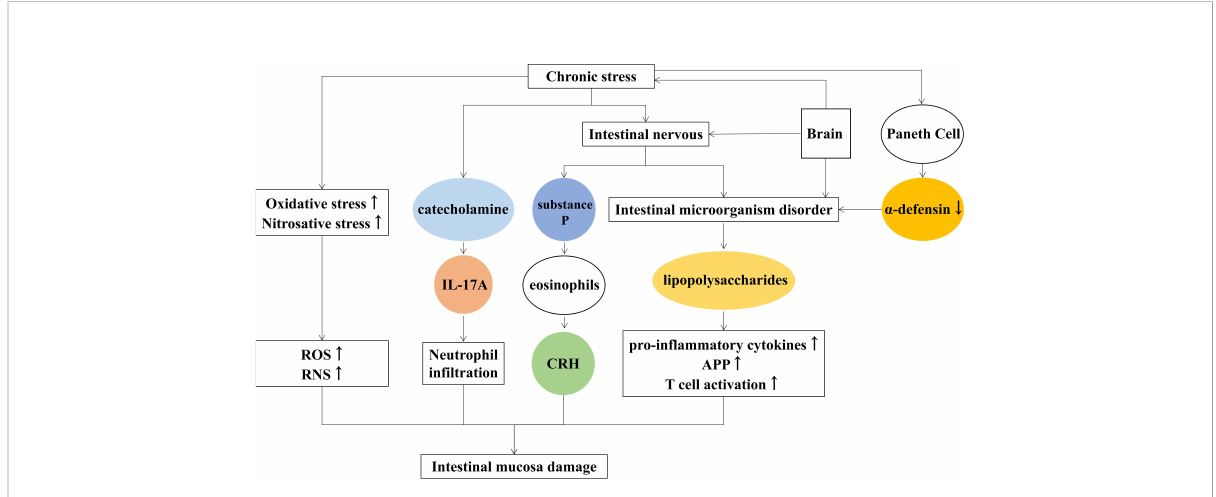
FIGURE 3 Mechanisms of chronic stress-induced intestinal mucosal